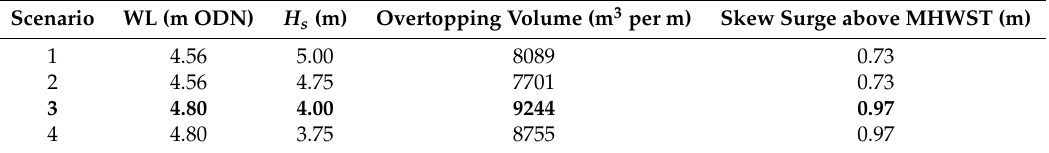
Table 1. H s -WL combinations extracted from the 1:200 year joint probability curve. Time-integrated overtopping volumes are provided from scenarios with morphological beach evolution enabled.